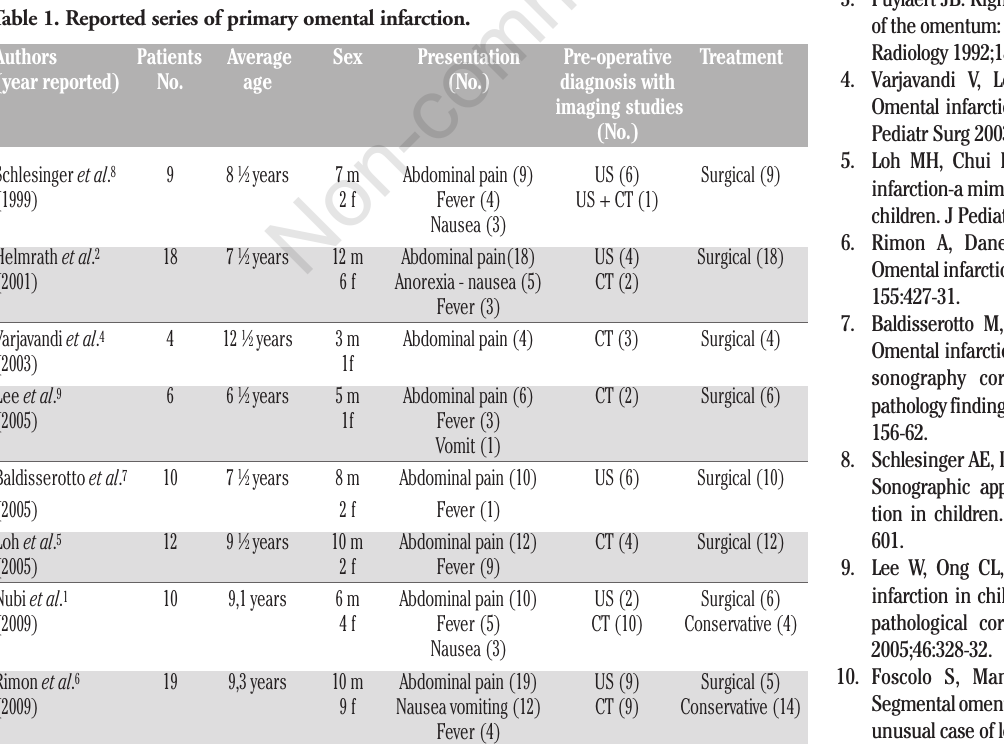
Table 1. Reported series of primary omental